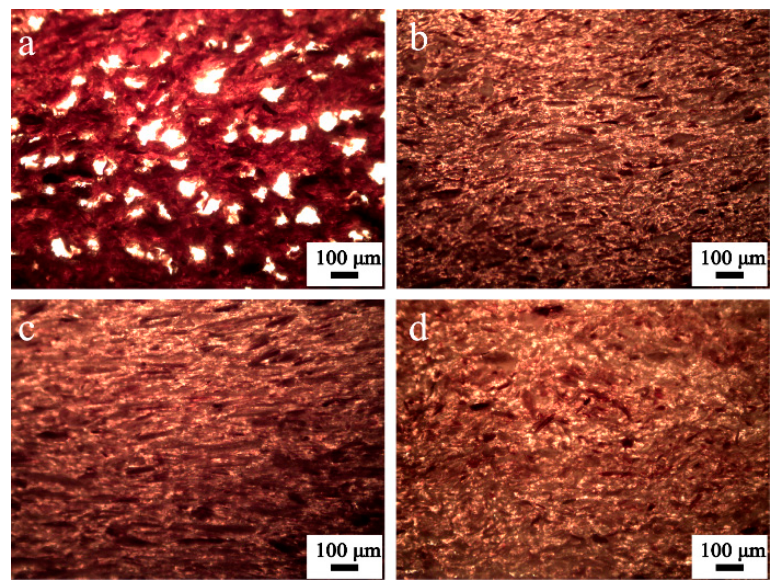
Figure 1. Optical micrographs of the internal state of ( a ) RS/HDPE, ( b ) CW/HDPE, ( c ) HW/HDPE, and ( d ) AL/HDPE.